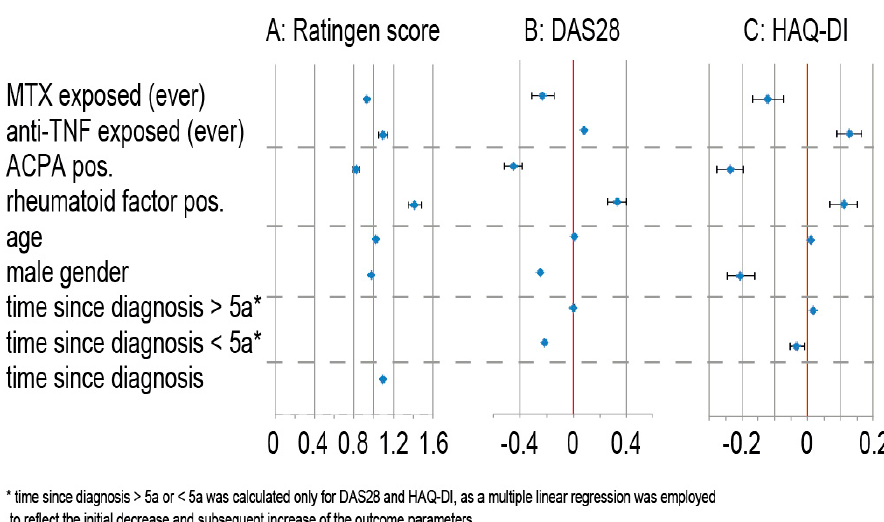
Figure 3. (Column A ) Results for the negative binomial regression model with the Ratingen score as outcome. The estimate for each of the parameters indicates the percentage change in Ratingen score associated with a change of said parameter. While most variables included in the model are binary, for the continuous variables, such as time since diagnosis and age, the estimates refer to an increase of the parameter by 1 unit. Values greater than 1 indicate a positive association, smaller than 1 indicate a negative association. Results for the linear regression models for (Column B ) the DAS28 score and (Column C ) the HAQ-DI. The estimate for each of the parameters indicates how much the score changes in absolute, if only this parameter changes. While most variables included in the model are binary, for the continuous variables, such as time since diagnosis and age, the estimates refer to an increase of the parameter by 1 unit. Values greater than 0 indicate a positive association, smaller than 0 indicate a negative association.